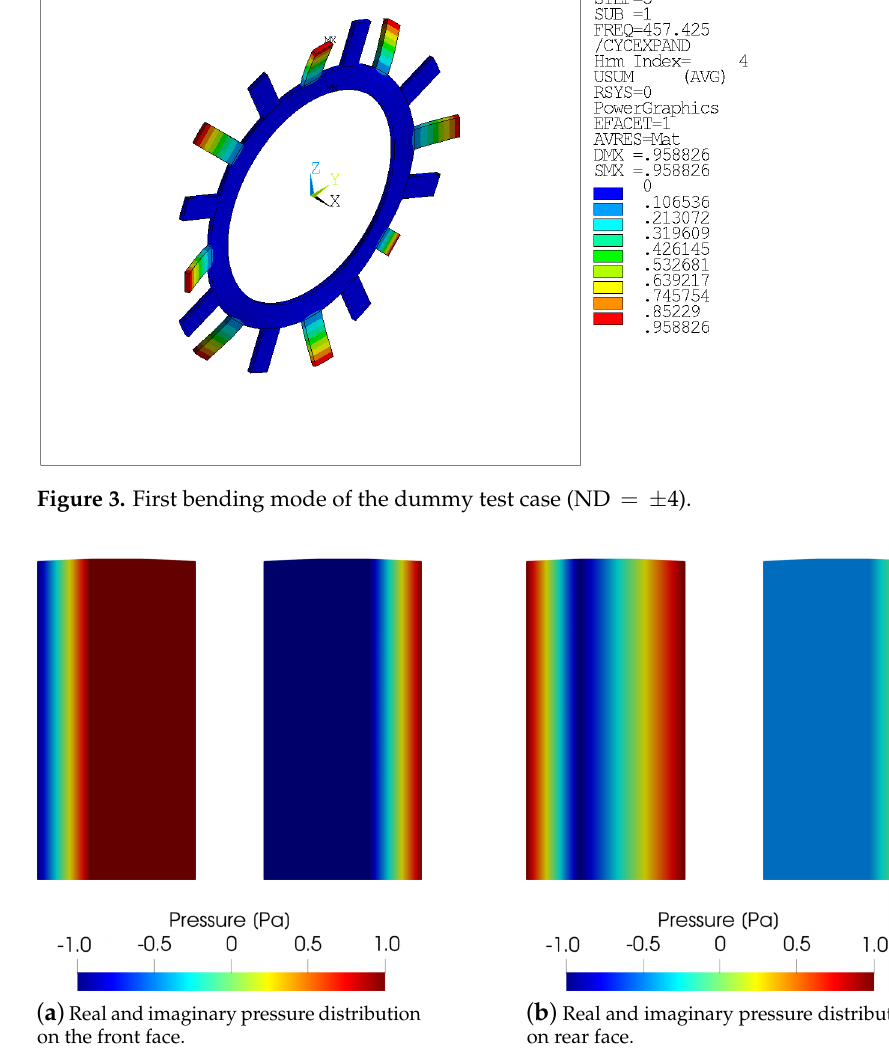
( b ) Real and imaginary pressure distribution on rear face.